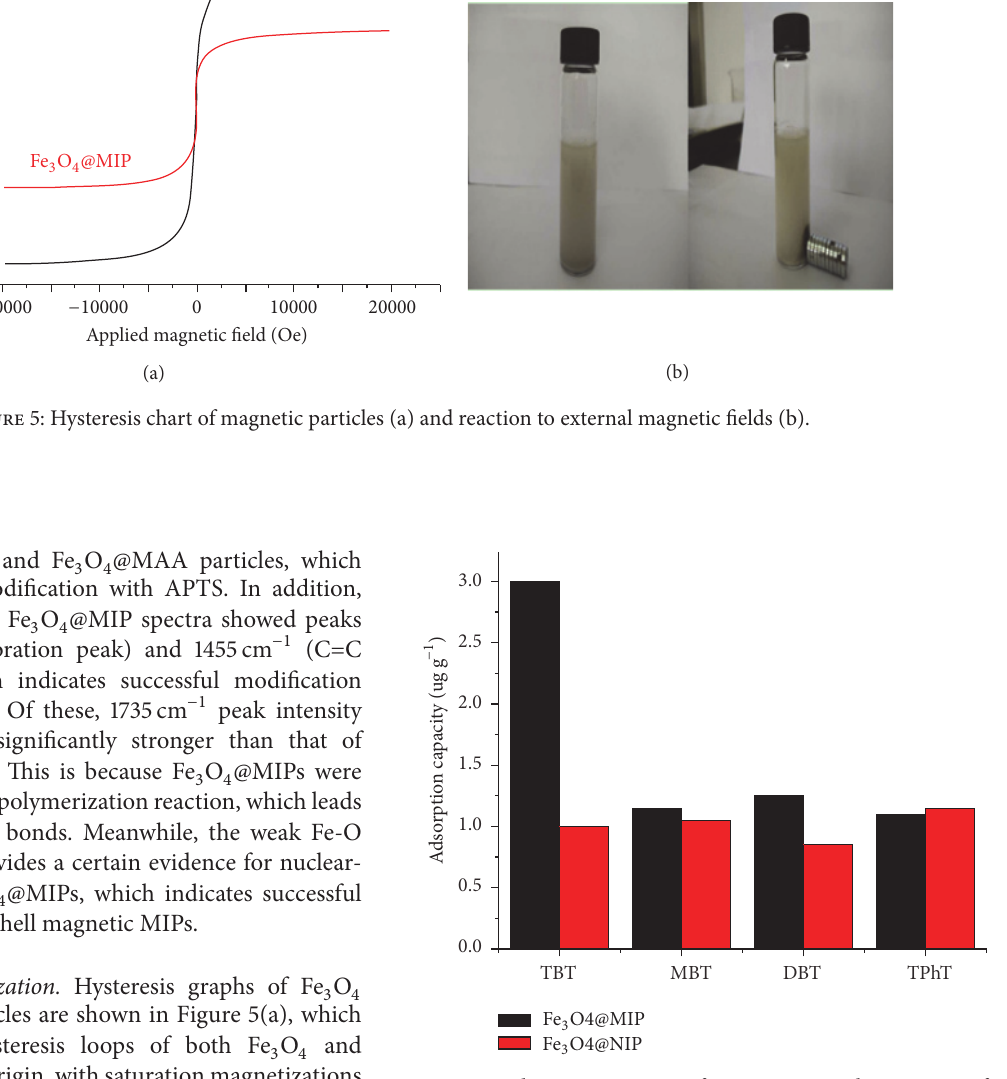
Figure 6: Adsorption capacity of Fe 3 O 4 @MIP and Fe 3 O 4 @NIP